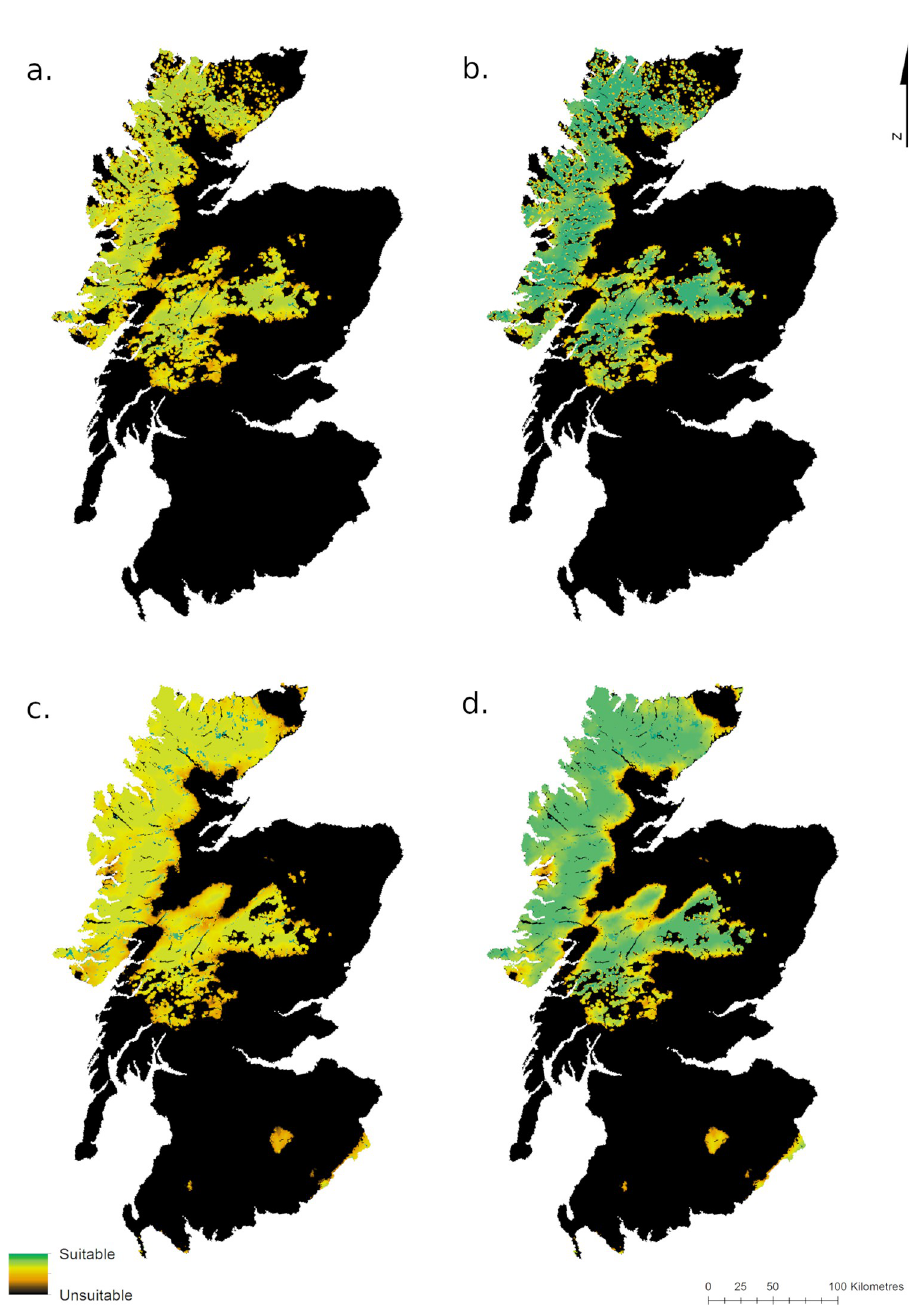
Fig 4. Overall wolf habitat suitability. Fuzzy overlay maps combining all four variables. Fig 4A corresponds to Model 1, Fig 4B to Model 3, Fig 4C to Model 4 and Fig 4D to Model 6 (Table 4).